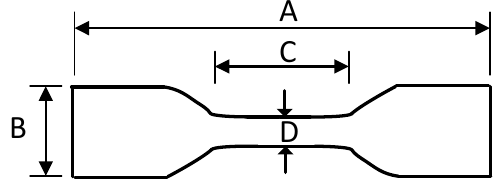
Figure 3. Sample for mechanical measurement.